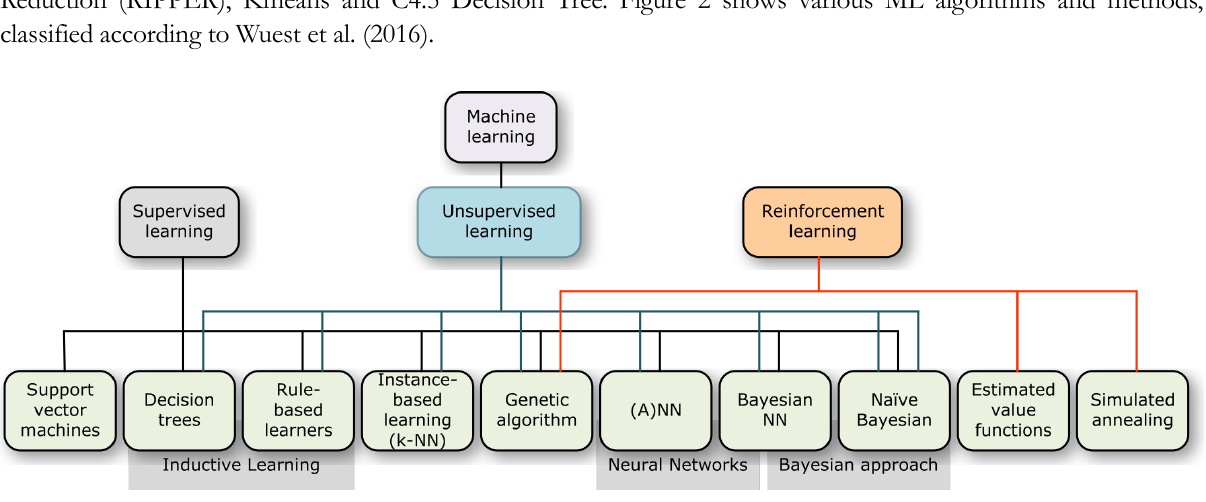
Figure 2. Classification of main ML